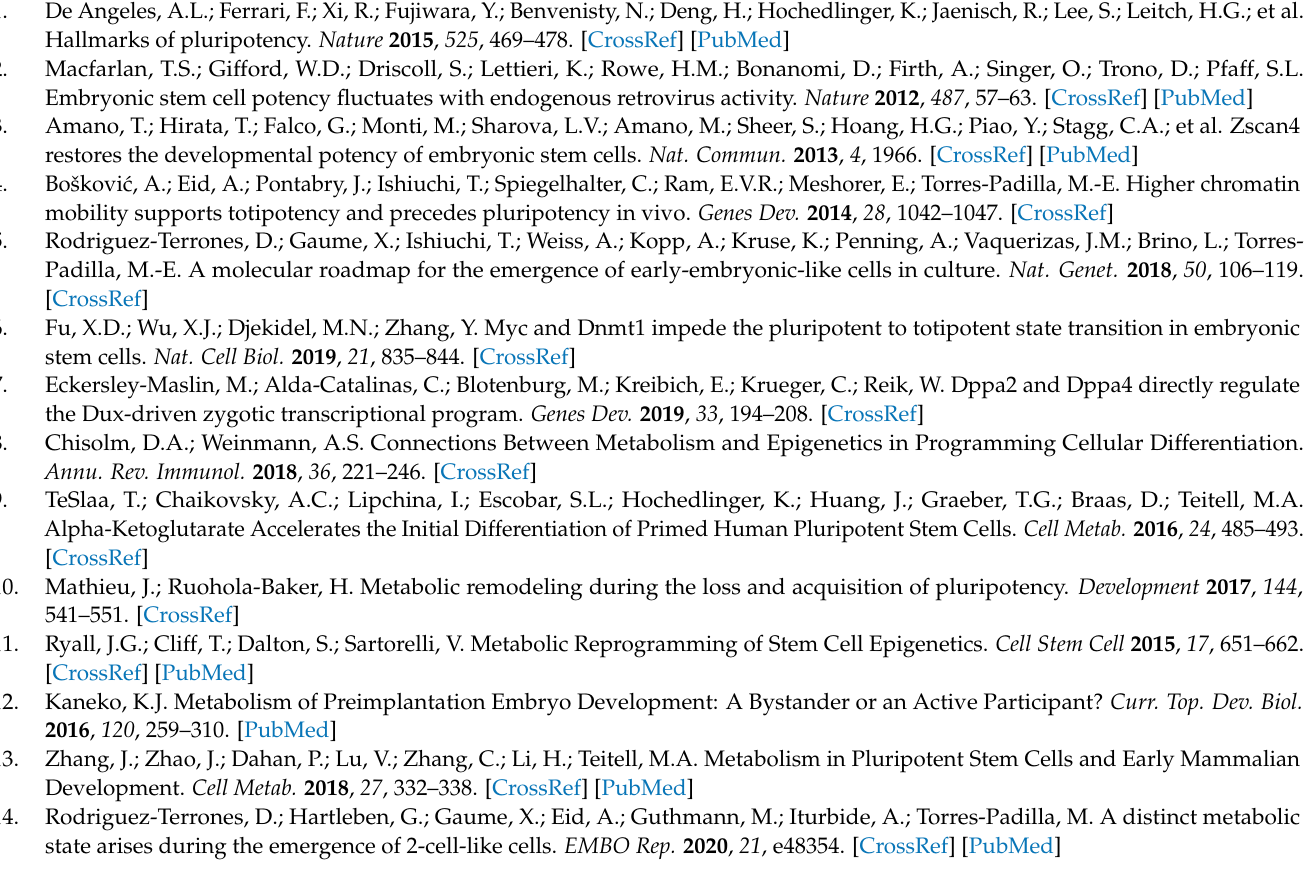
Table S2: GO-Up regulated genes; Table S3: GO-Down regulated